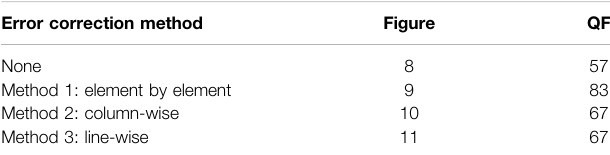
TABLE 1 | Quality factor of images obtained with multiplexing and error corrections. Error correction method